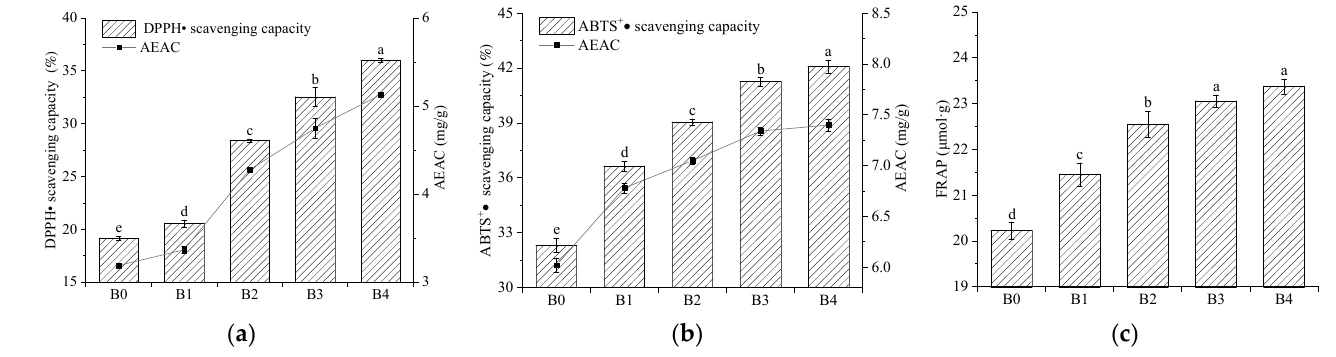
Figure 10. The antioxidant activity of wheat bran in vitro: ( a ) DPPH• scavenging capacity; ( b ) ABTS + • scavenging capacity; ( c ) Ferric reducing antioxidant power (FRAP). The B0, B1, B2, B3, and B4 are the wheat bran prepared under the rolling frequencies 0, 6, 9, 12, and 15 times. AEAC is the VC equivalent (mg/g). Different lowercase letters on the shoulders of the column indicate significant differences ( p < 0.05).